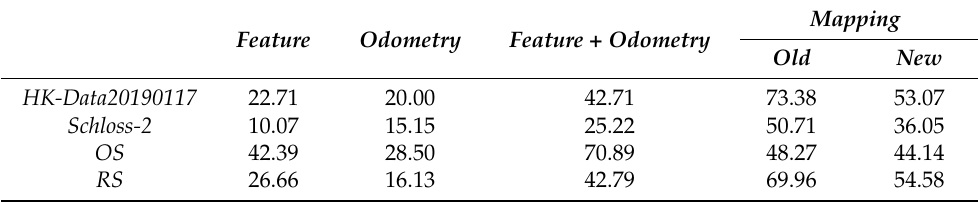
Table 4. Average runtime of VLOM on HK-Data20190117 , Schloss-2 , OS , and RS . The results are presented in ms